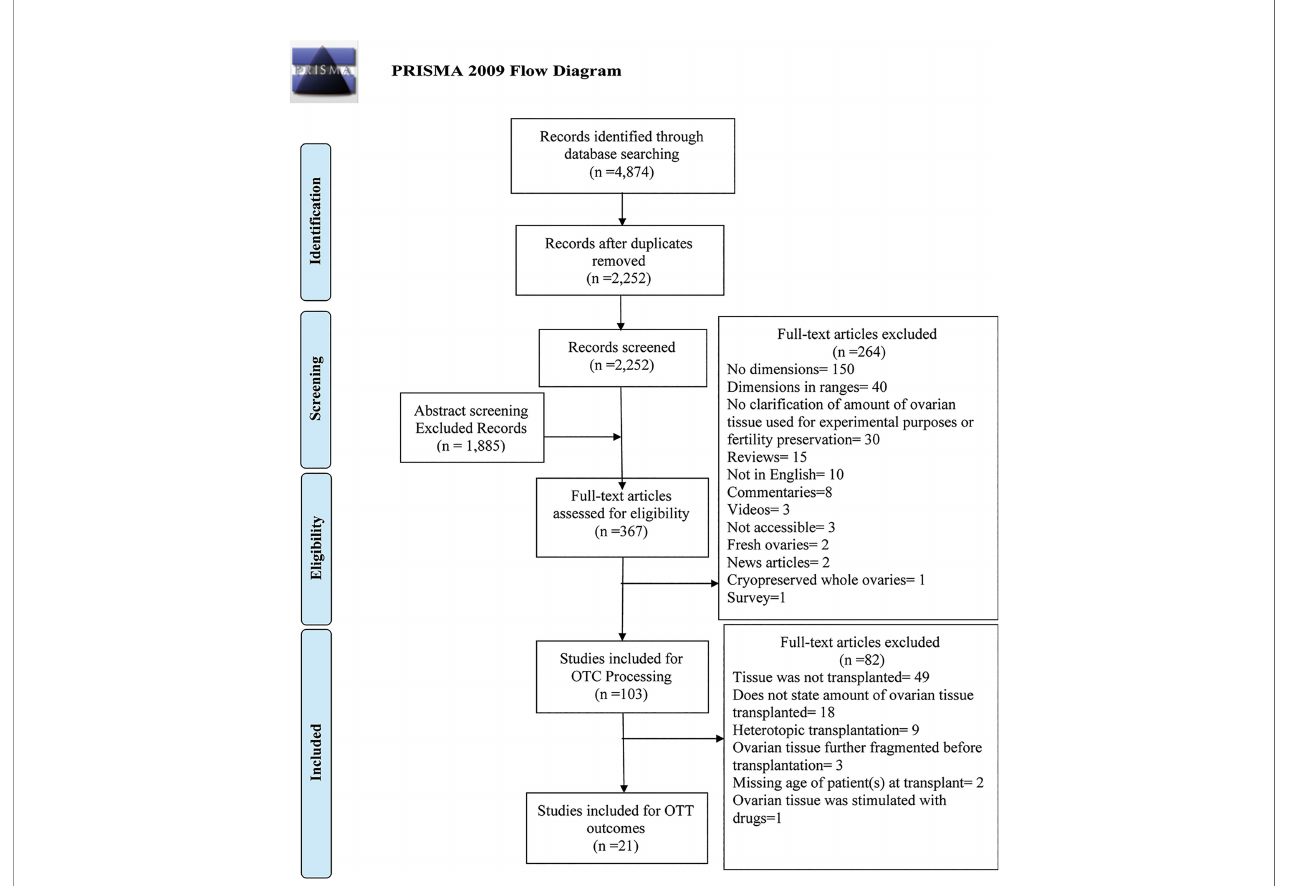
FIGURE 1 | PRISMA Flow diagram for ovarian tissue cryopreservation and